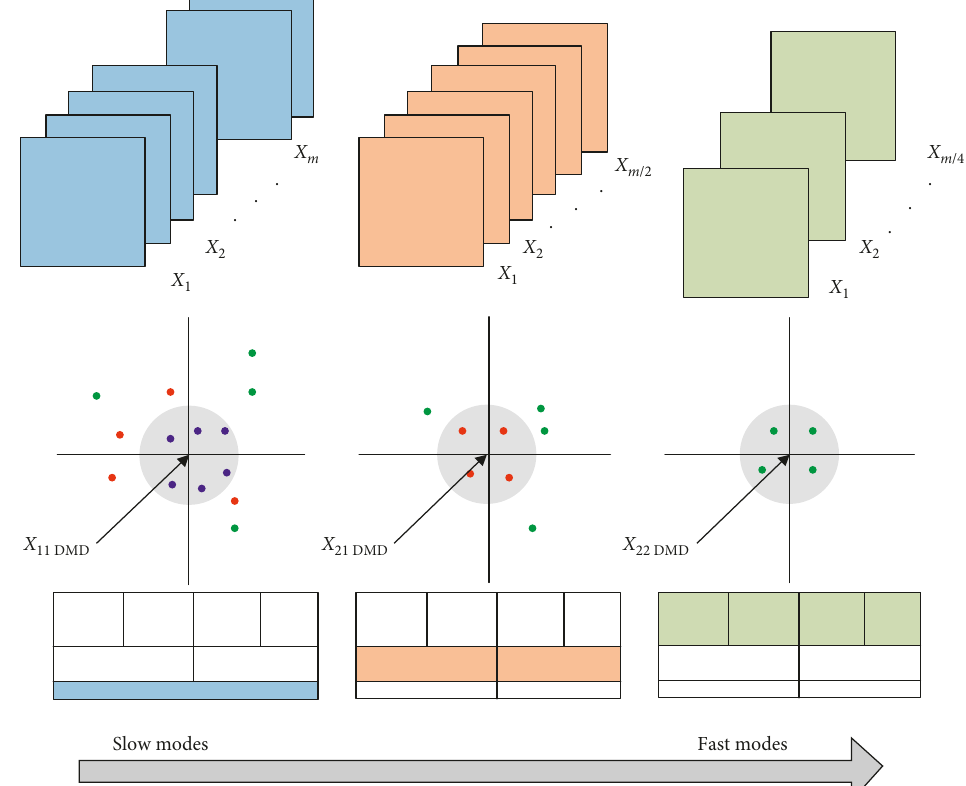
Figure 2: Illustration of mrDMD solution. Here, the slow modes and fast modes are divided by splitting the number of ϖ